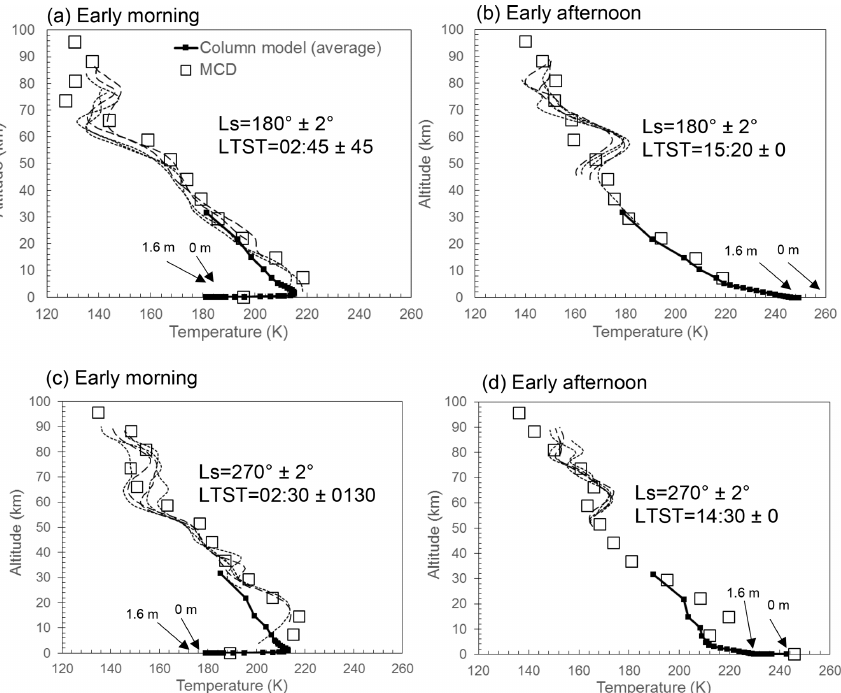
Figure 4. VL-1 site MCS temperature soundings and model temperatures compared. As for Fig. 3 but for the autumn equinox ( L S 180 ◦ ) and the winter solstice ( L S 270 ◦ ). Five MCS soundings are plotted in each figure. See the caption of Fig. 3 for preceding seasons and details regarding the profile locations and an explanation of the legends. Also shown are the 1.6m altitude temperature measurements and inferred surface temperature from Paton et al. (2016). Overlaid, as a check, are data from the